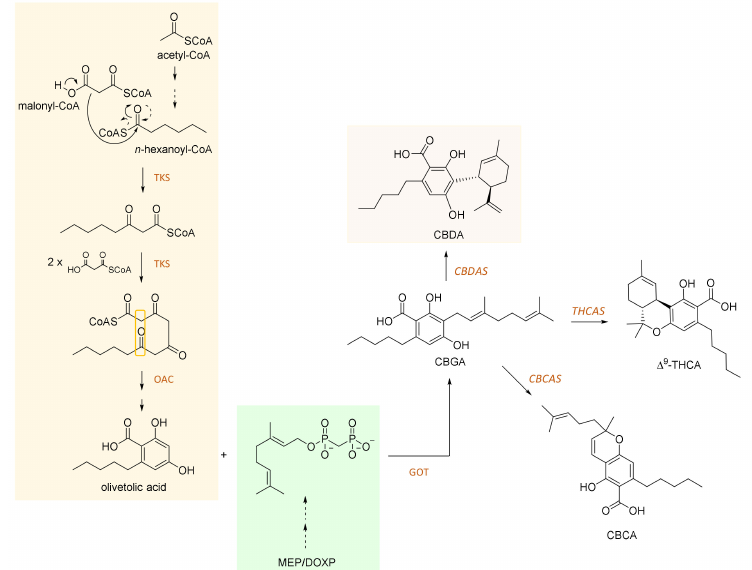
Figure 1. Schematic pathway for CBDA, THCA, and CBCA biosynthesis. Tetraketide synthase